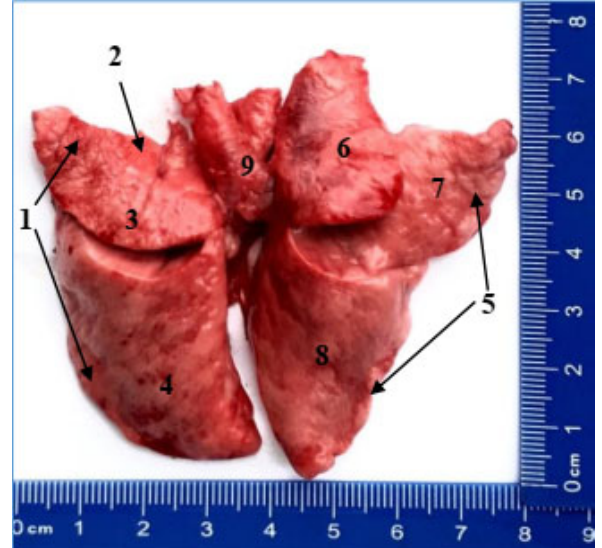
Fig. 2. Fragment of the histological structure of the lung of a mature rabbit: 1 – longitudinal section of the small bronchus; 2 – alveolar sacs; 3 – alveolar ducts; 4 – vessels. Hematoxylin and eosin. X 120